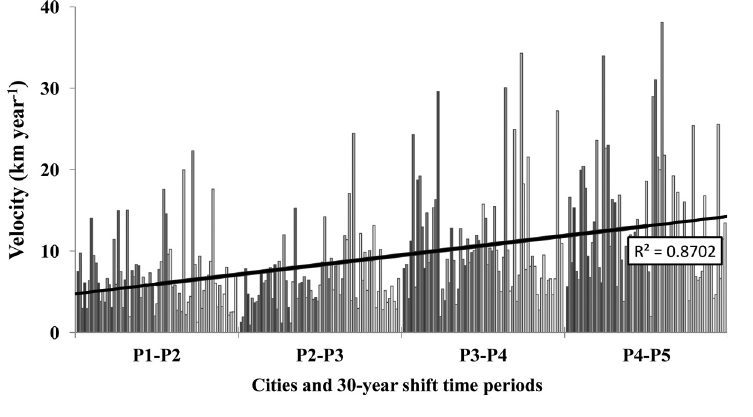
Figure 4. Southward velocity of the investigated cities for each 30-year